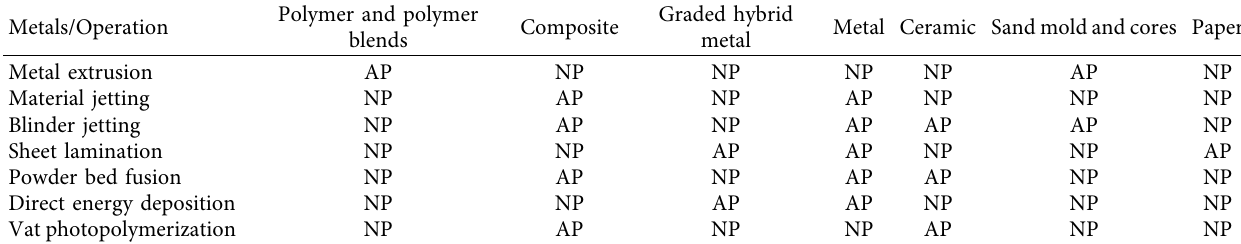
Table 1: Different materials and operation of AM [28].